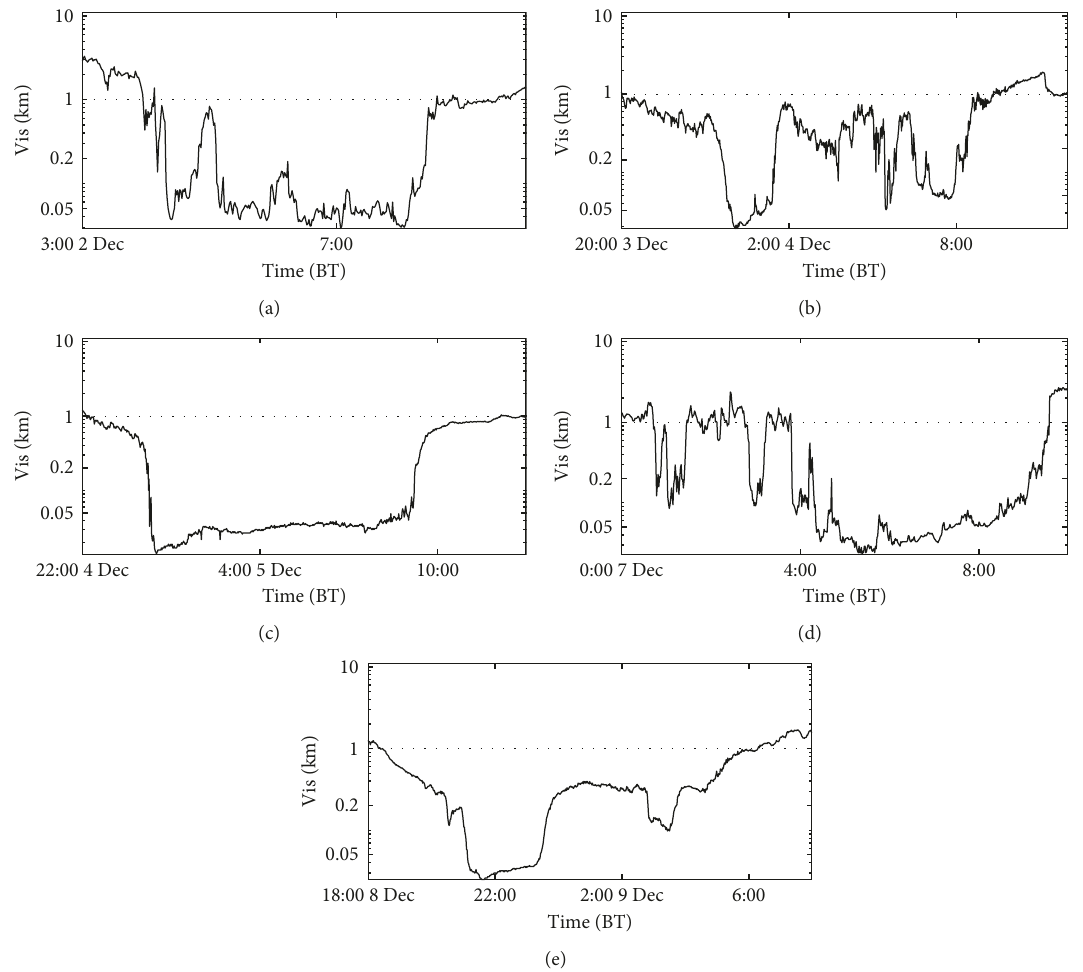
Figure 3: Temporal variation of visibility during five explosive processes at the Sheyang site. (a) Case 1: from 03:00 BTon 2 December